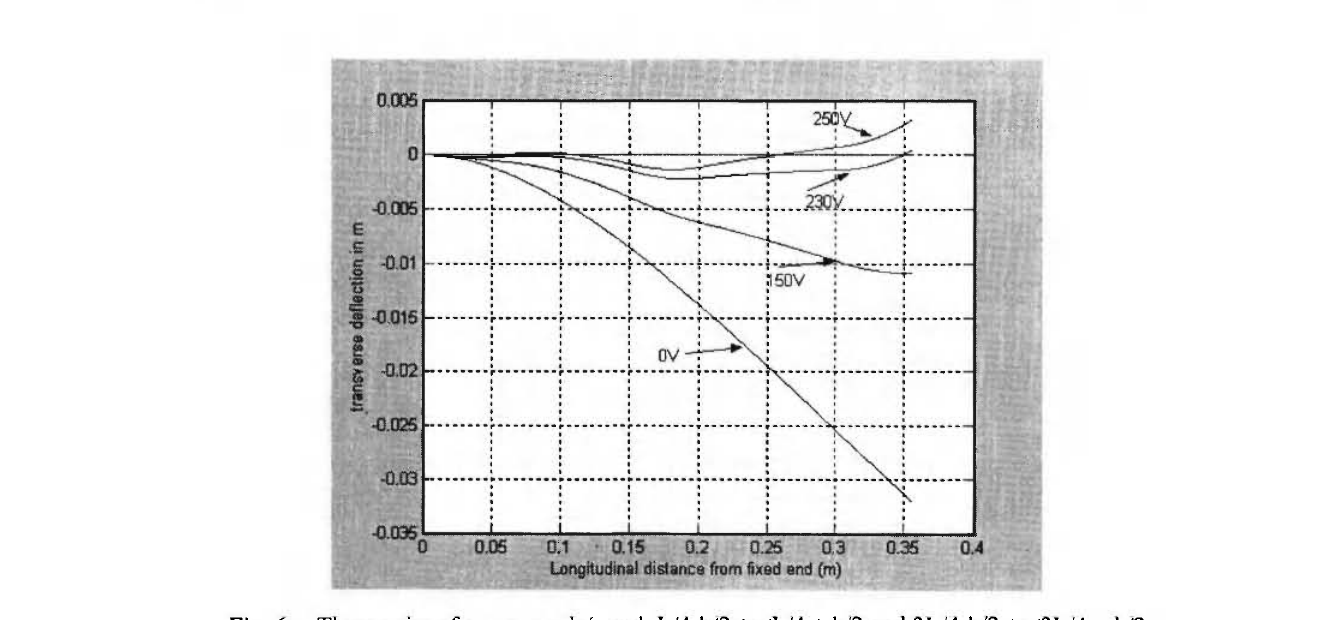
Fig. 6: Three pairs of actuators: left end, L/4-b/2<x<L/4 + b/2 and 3L/4-b/2<x<3L/4 + b/2